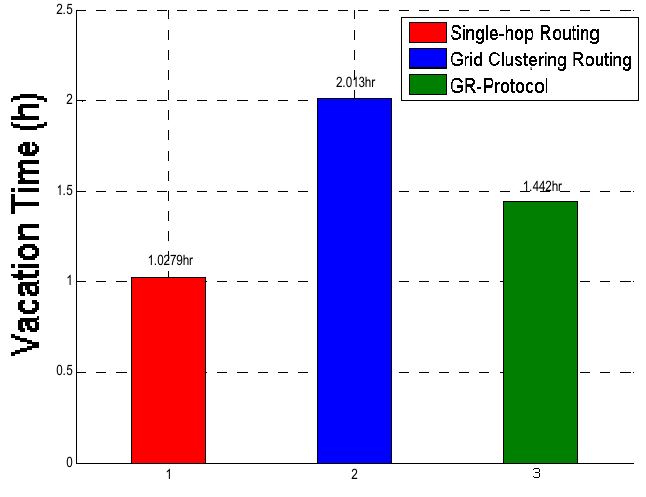
Figure 12. Comparative vacation times of the WPCD.